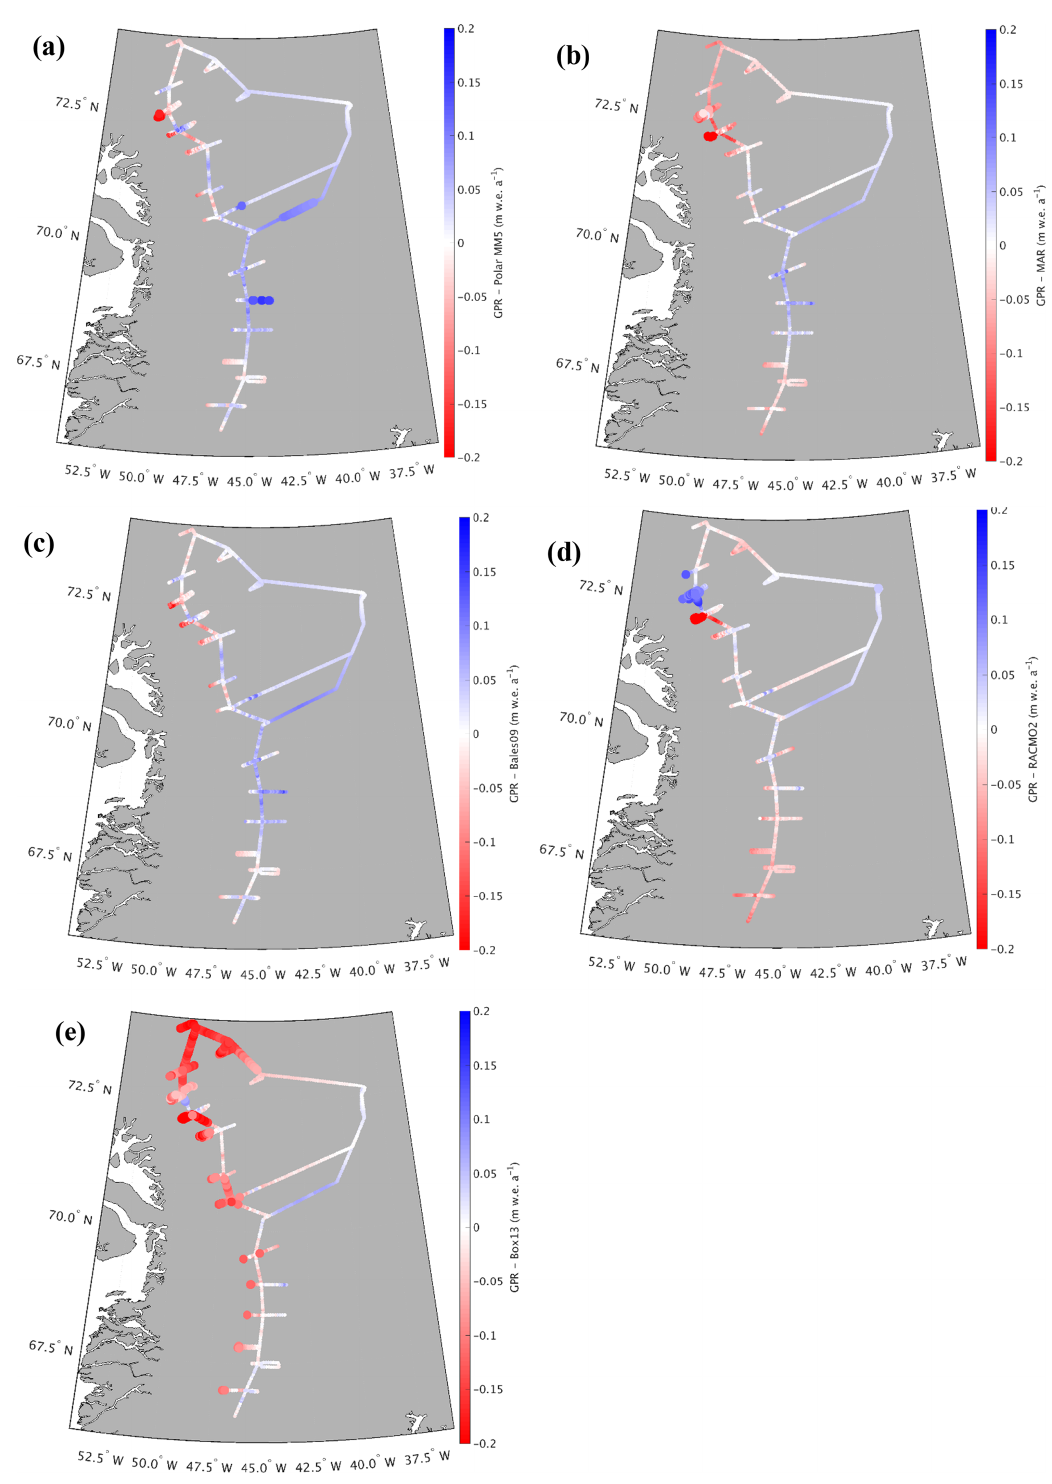
Figure 9. Differences between GreenTrACS accumulation rates and (a) Polar MM5, (b) MAR, (c) Bales09, (d) RACMO2, and (e) Box13 accumulation rates averaged over the corresponding time periods. Large dots show statistically significant differences from GreenTrACS accumulation